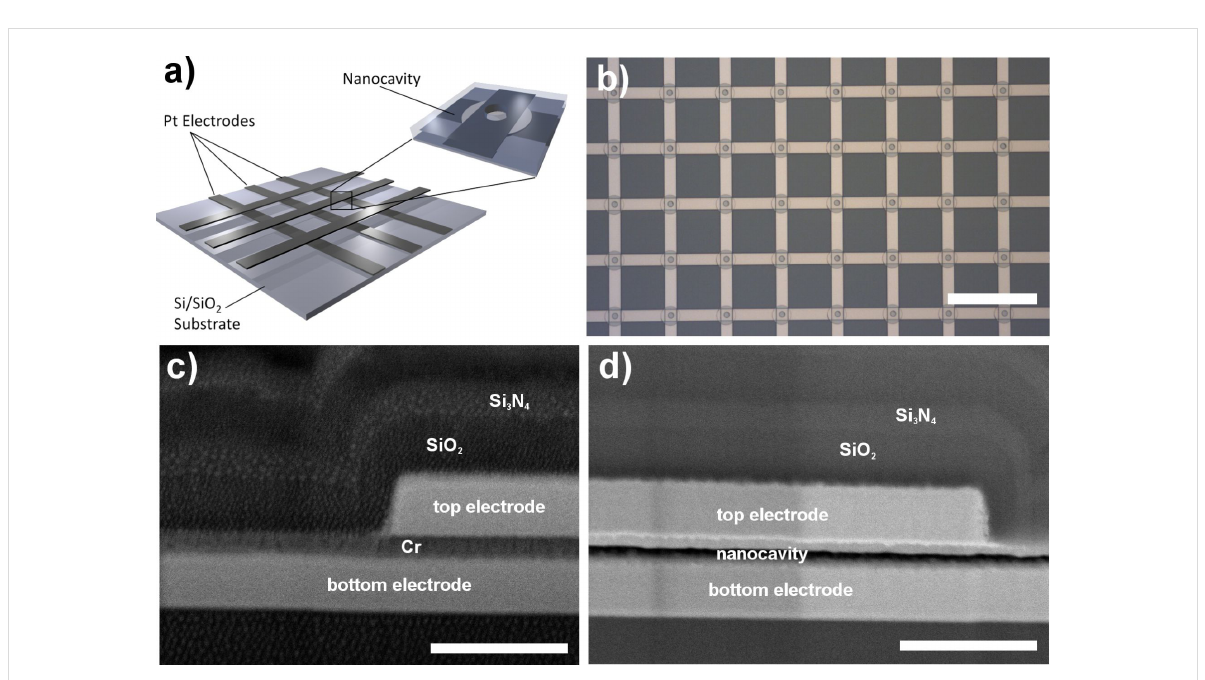
Figure 6: Nanocavity array chip: a) Illustration of a sensor array. The inset sketches a nanocavity sensor that can be found at each feed-line intersec- tion. The light grey spherical layer represents the nanocavity, while the hole in the top electrode and in the passivation layer is the access channel that connects the bulk reservoir on the chip surface to the nanocavity. b) Microscopic top view of a part of the array. c,d) Scanning electrochemical micro- scope images of FIB-induced cross sections of a nanocavity sensor before (c) and after (d) removal of the sacrificial chromium layer. The scale bars for the images in (b), (c), and (d) are 100 μ m, 400 nm, and 400 nm,